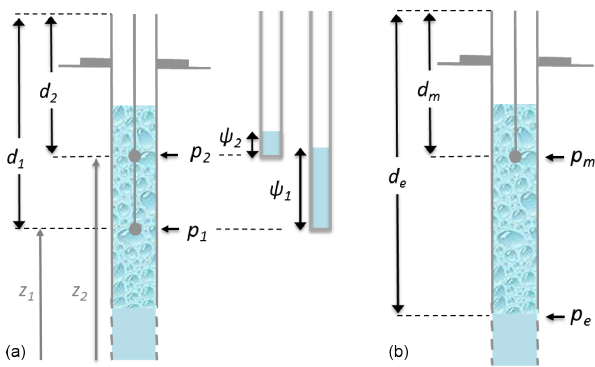
Figure 3. Measurement of pressure in the borehole with ascending bubbles: the measured pressure p and the related pressure head ψ at two different depths d 1 and d 2 within the bubble column using the (a) differential method ; pressure within the bubble column p m and beneath p e used to determine the mean bubble fraction using the (b) integral method . Note that the difference in altitudes z 2 − z 1 = d e − d m